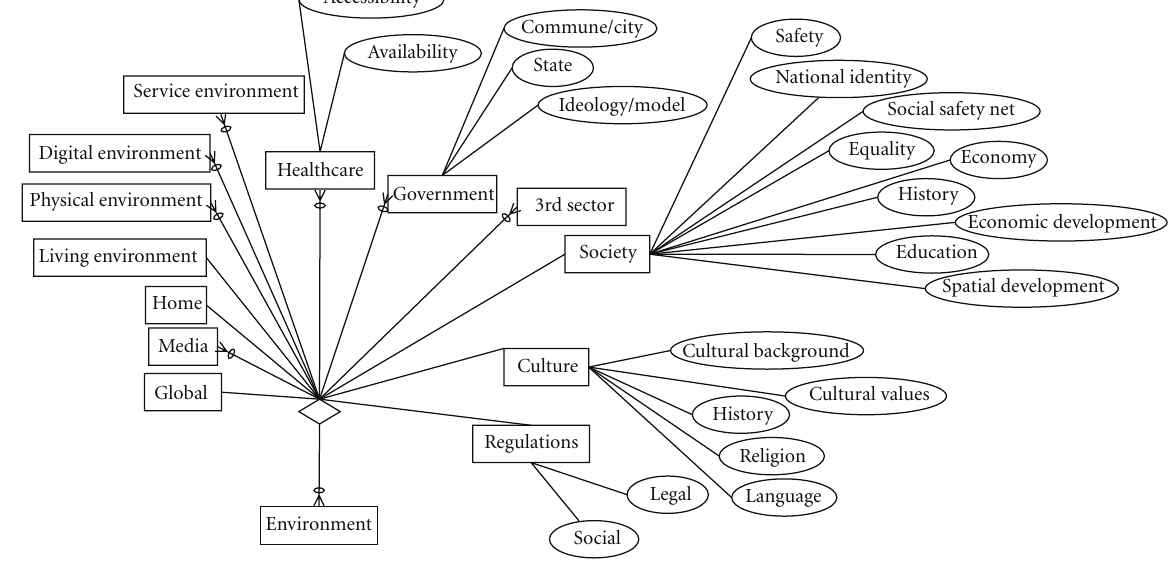
Figure 3: The environment component.